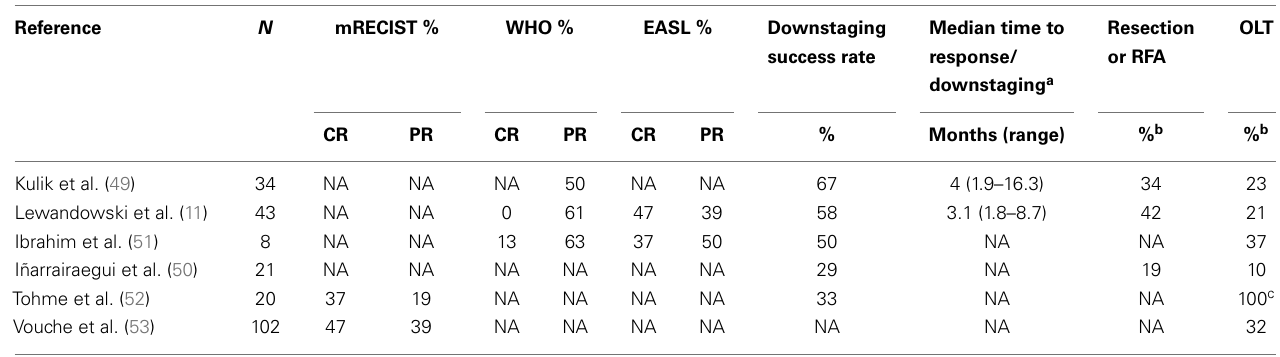
Table 2 | Response assessment and downstaging in HCC patients